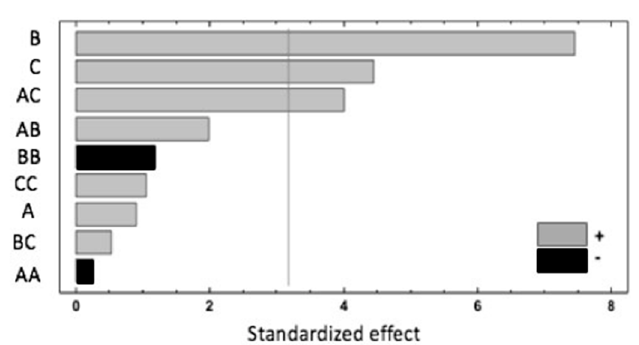
Figure 1. Pareto chart of factors and interactions obtained from the Box–Behnken design (BBD) for the response, where A = sample weight, B = extraction temperature and C = extraction time.